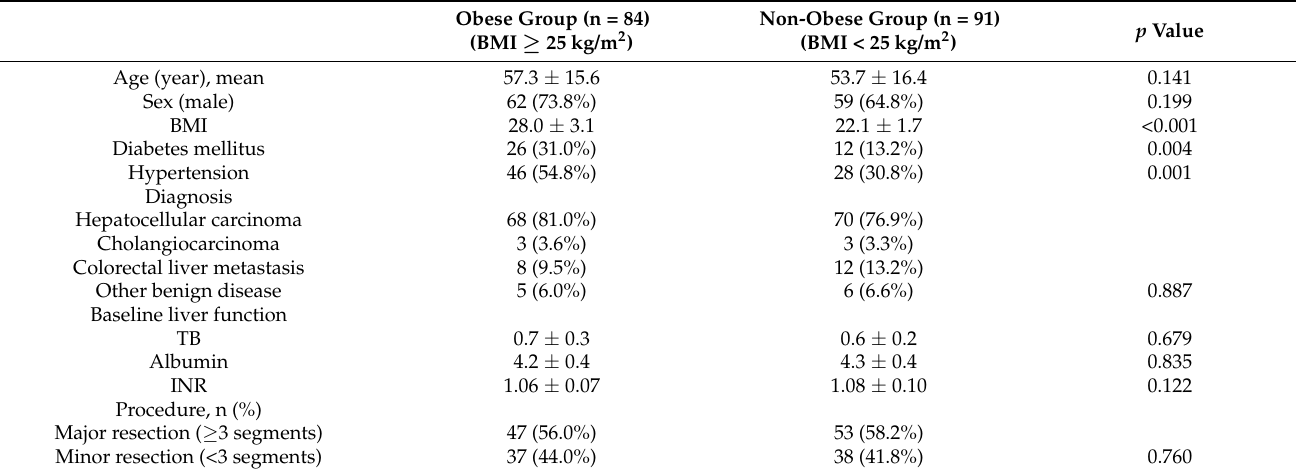
Table 1. Clinico-demographic characteristics of